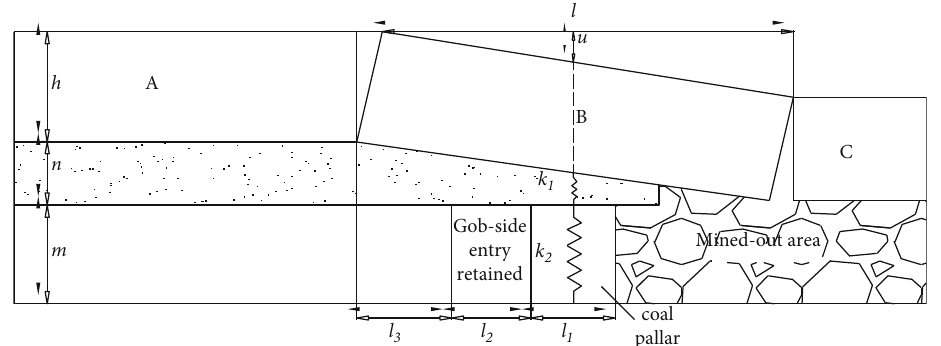
Figure 9: Mechanical model diagram of coal